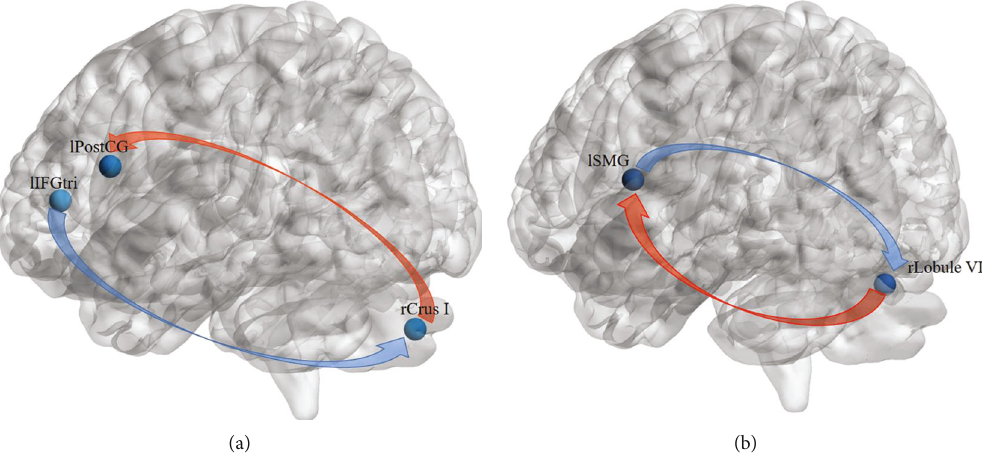
Figure 7: Aberrant e ff ective connectivity from and to rCrus I as well as from and to rLobule VI. (a) Using rCrus I as an ROI, decreased EC from the lIFGtri to rCrus I and increased EC from rCrus I to the lPostCG were found. (b) Using rLobule VI as an ROI, decreased EC from the lSMG to rLobule and increased EC from rLobule VI to the lSMG were